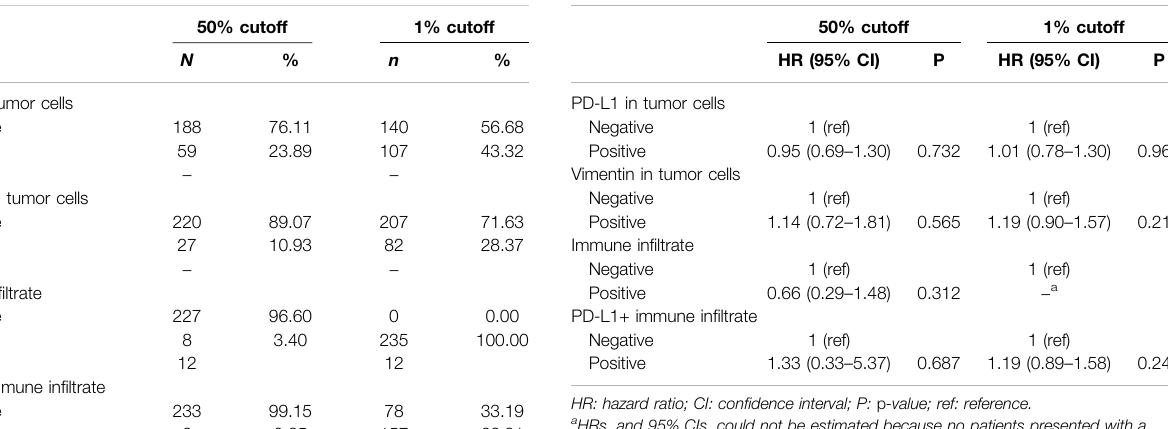
TABLE 5 | Results from univariate Cox models for dichotomized biomarkers.